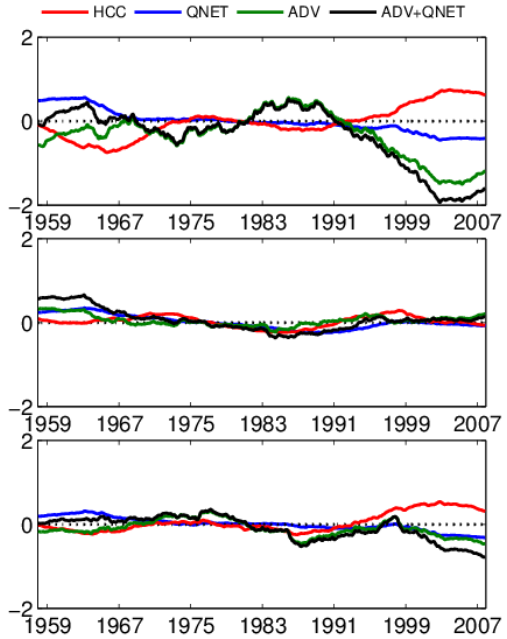
Fig. 4. Time series of 10yr running mean HCC (red), QNET (blue) Figure 4 Time series of 10-yr running mean HCC (red), QNET (blue) and ADV 345 and ADV (green) in Box 1 (top), Box 2 (middle) and Box 3 (bot- (green) in Box 1 (top), Box 2 (middle) and Box 3 (bottom), Units: TW, where 1 346 tom); units: TW, where 1 TW = 10 12 TW=10 12 W. 347